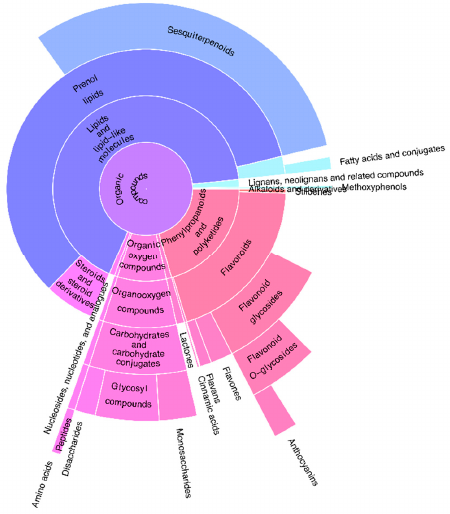
Figure 1. The sunburst plot shows an overview on the classified compound classes in all of the tested bryophyte species. The membership of chemical entities is aggregated and displayed together with all parent compound classes. The width of a compound class in the plot corresponds to the number of chemical entities assigned to this particular class. Our classifier assigned chemical entities to 24 classes out of 35 predefined classes (Table 1). From a total of 10,436 spectra 201 spectra were not matched into any of the classes. Our classifier did not assign fragment spectra to the classes of monoterpenoids, diterpenoids, triterpenoids, benzene and substituted derivatives, benzoic acids, phthalic acid and derivatives, coumarins and derivatives, biflavonoids and polyflavonoids, oligosaccharides, polysaccharides, organic acids and derivatives. Table 1. List of classified compound classes and the corresponding area under precision – recall curve (AUC-PR) and the true positive rate for a fixed false negative rate of 5% (TPR-FNR) determined by our classifier in all of the bryophyte samples. The higher the AUC-PR value the better was the performance of the classifier. Generally, values above 0.5 are considered to be a good performance metric with imbalanced data [53]. The higher the TPR-FNR the larger was for the probability that the classifier assigned chemical entities correctly to a compound class. A value of 0 means for both metrics that the classifier could not assign enough spectra to a particular compound class.